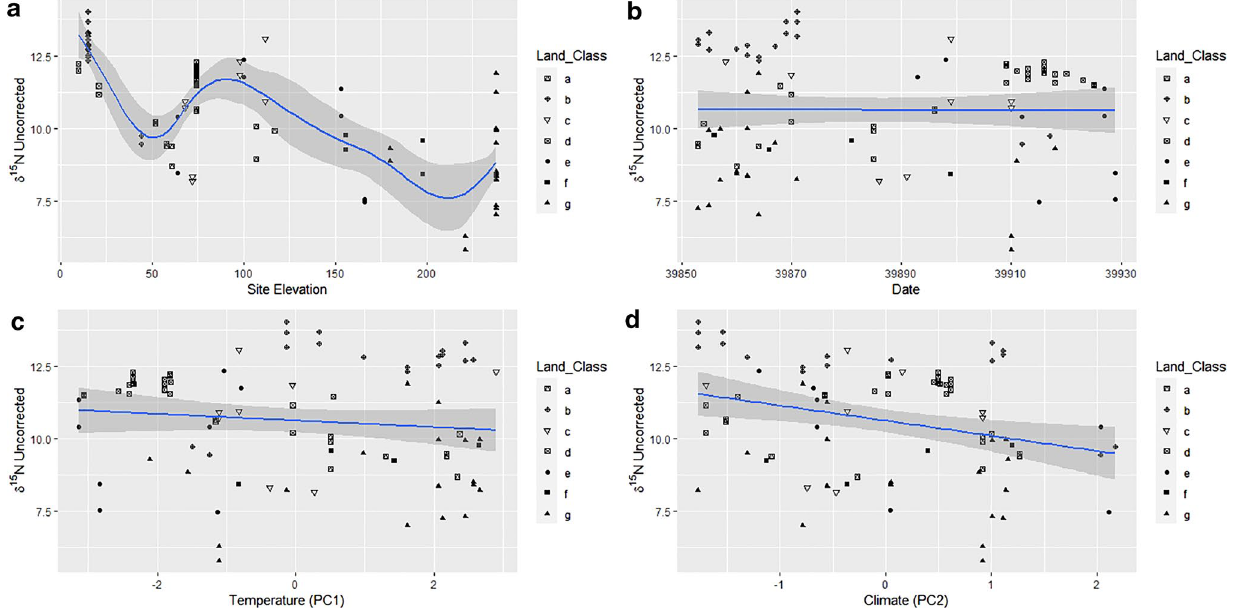
Figure 8. GAM factors smoothed for the hair dataset. Corrected δ 13 C versus ( a ) Site Elevation, ( b ) Date, ( c ) Temperature PC1 and, ( d ) Climate PC2. Solid lines indicate the trend line, and the shaded area is the approximate 95% point-wise confidence